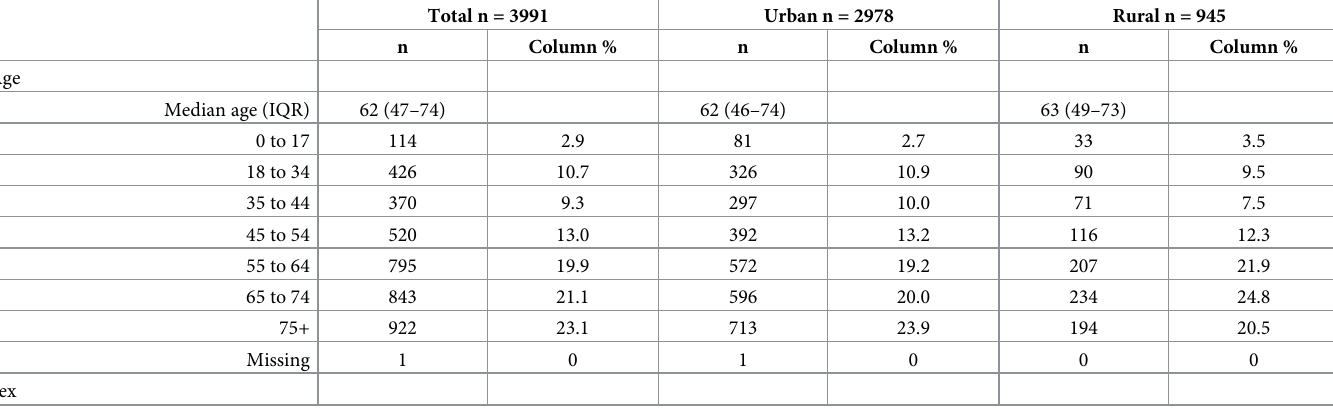
Table 1. Demographics, characteristics and comorbidities of patients hospitalized with a SARS-CoV-2 infection or COVID-19 diagnosis, total and stratified by rural/urban zip